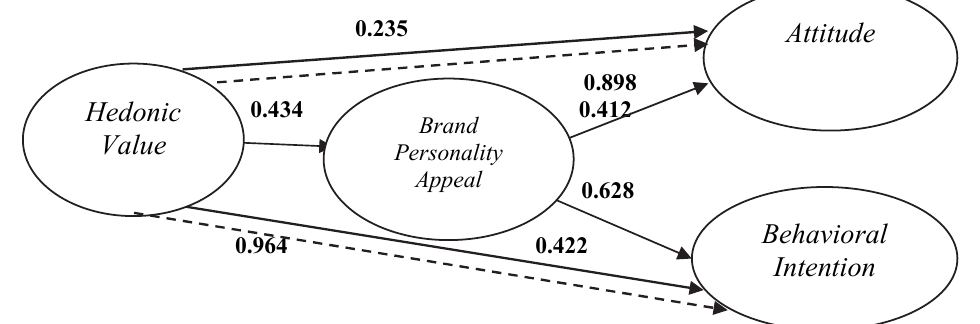
Fig. 2. Hedonic Value Coefficient Diagram towards attitude and behavioral intention through brand